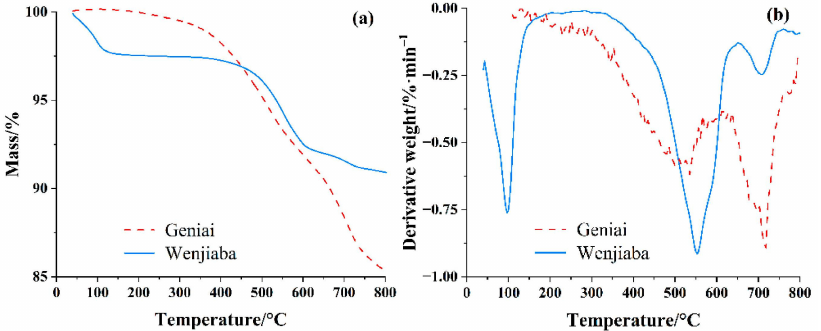
Figure 3. ( a ) Mass loss and ( b ) mass loss rate curves for the shale samples in nitrogen conditions.